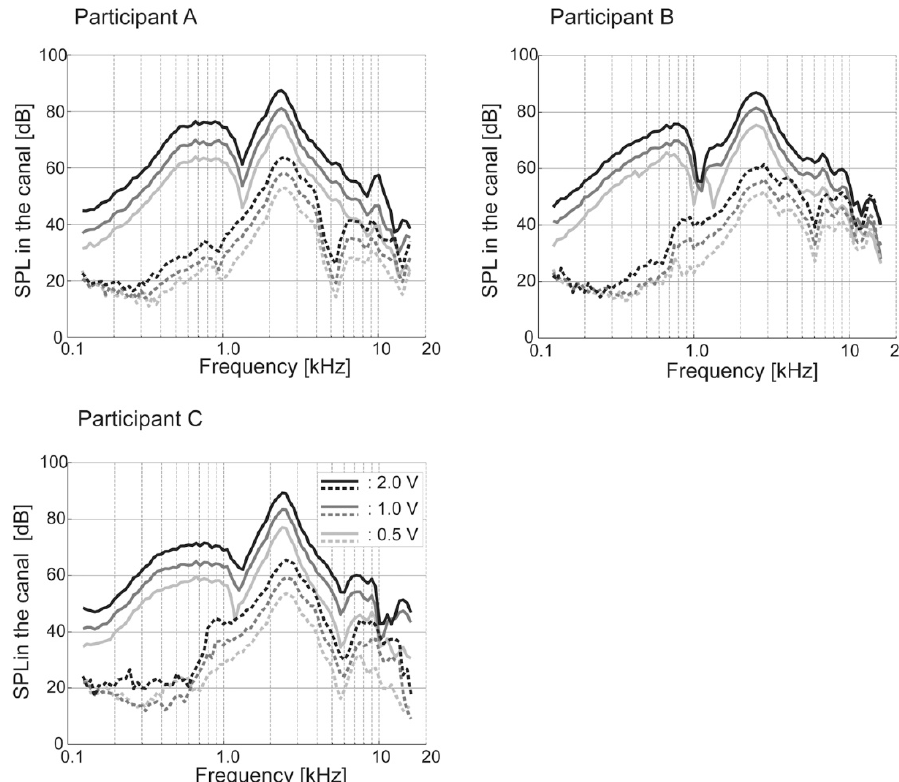
Figure 2. Sound pressure level (SPL) in the canal when the transducer is attached to the tragus (—) and unattached (- - -). The black, dark gray, and gray lines indicate input voltages of 2.0, 1.0, 0.5 V, respectively. (Figure 2 was originally presented in Shimokura et al. 2014, Figure 6 [13]).